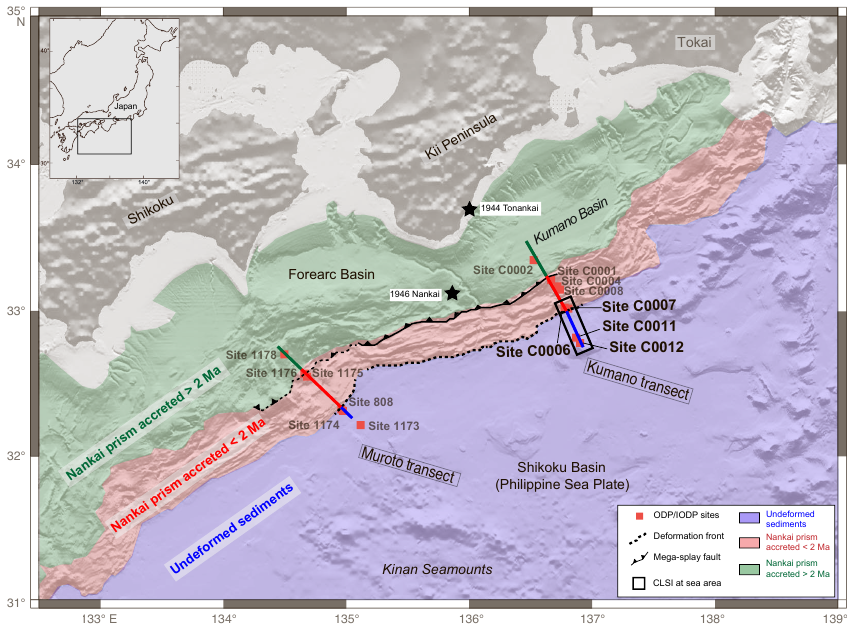
Figure 1. Synthesis map of the Nankai Trough offshore southwestern Japan. The area of investigation of the CLSI@Sea workshop corre- sponds to the black frame, including Site C0006, the target of IODP Expedition 380. The colors show the stage of evolution of the deforma- tion within the Nankai Trough. The two sections across the Kumano and Muroto transects are shown in Fig. 2. Compiled and modified from Kimura et al. (2014) and Moore et al. (2001, 2009).